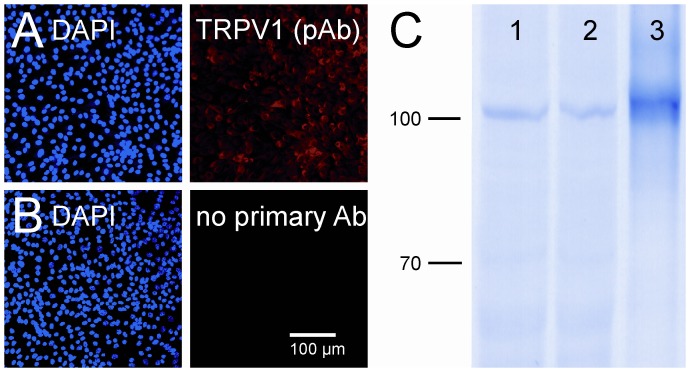
TRPV1 expression in human cultured PTEC.
A. Human PTECs were marked with DAPI and stained with a primary anti-TRPV1 antibody (giunea-pig polyclonal serum); omission of a primary antibody served as negative control (B). C. In addition TRPV1 was assessed in lysates of unstimulated (1) or TNF-α stimulated PTECs (2) by Western blotting. TRPV1 transfected HEK cells (3) were used as positive control to indicate the molecular weight of TRPV1.